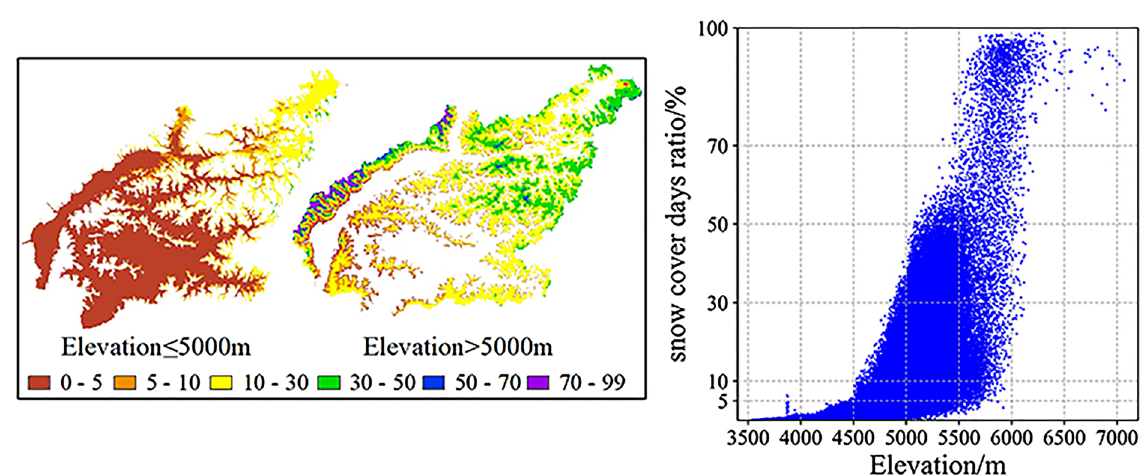
Figure 6. Snow cover days ratio (%). The daily MODIS cloud-free snow cover product over the Tibetan Plateau (2002–2015) with 0.005° resolution 32 was used to analyze the distribution characteristics of snow cover. The left figure showed the ratio of the proportion of days covered by snow to the total days from 2003 to 2014. To obtain intuitive changes in snow cover days with elevation, the gridded result is divided into two maps according